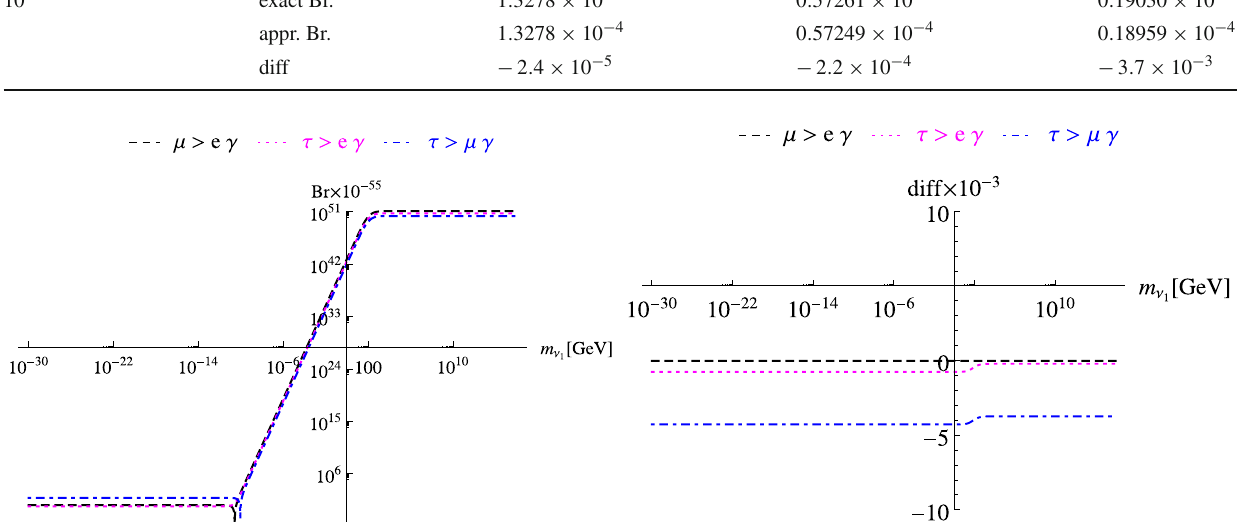
, which we deliberately 1